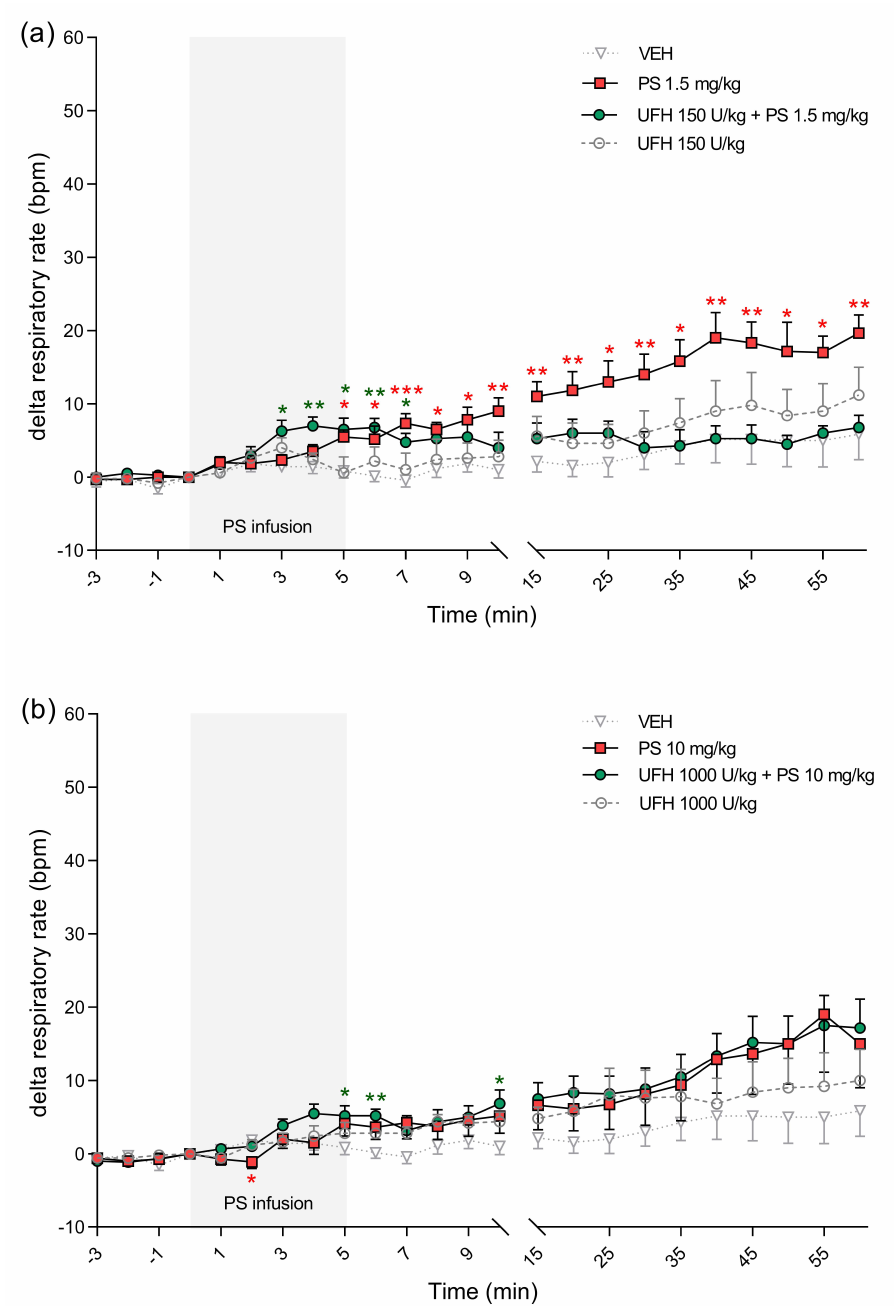
Figure 10. The effects of protamine sulfate (PS) and its complexes with unfractionated heparin (UFH) on respiratory rate. The course of respiratory rate was tracked for 60 min after short–duration intravenous infusion (5 min; 2 mL/h) of PS at dose of 1.5 ( a ) or 10 mg/kg ( b ) following intravenous administration of vehicle (VEH, 1 mL/kg) or UFH (150 or 1000 U/kg, 1 mL/kg). Results are shown as means (lines) with SEMs. The respiratory rate at 0 min of the experiment were 68 (43–88) for VEH, 68 (63–70) for PS 1.5 mg/kg, 76 (65–83) for UFH 150 U/kg + PS 1.5 mg, 64 (50–75) for UFH 150 U/kg, 67 (48–90) for PS 10 mg/kg, 67 (40–95) for UFH 1000 U/kg + PS 10 mg/kg, 52 (41–59) for UFH 1000 U/kg. Note: * p < 0.05, ** p < 0.01, *** p < 0.001 vs. VEH, Kruskal–Wallis ANOVA with Dunn’s post–hoc test, n =